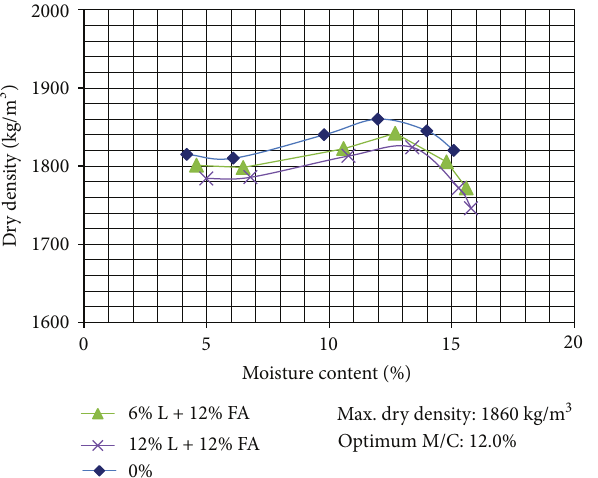
Figure 10: Compaction curve of unstabilized and stabilized WDA specimens at different contents of lime and fly ash.